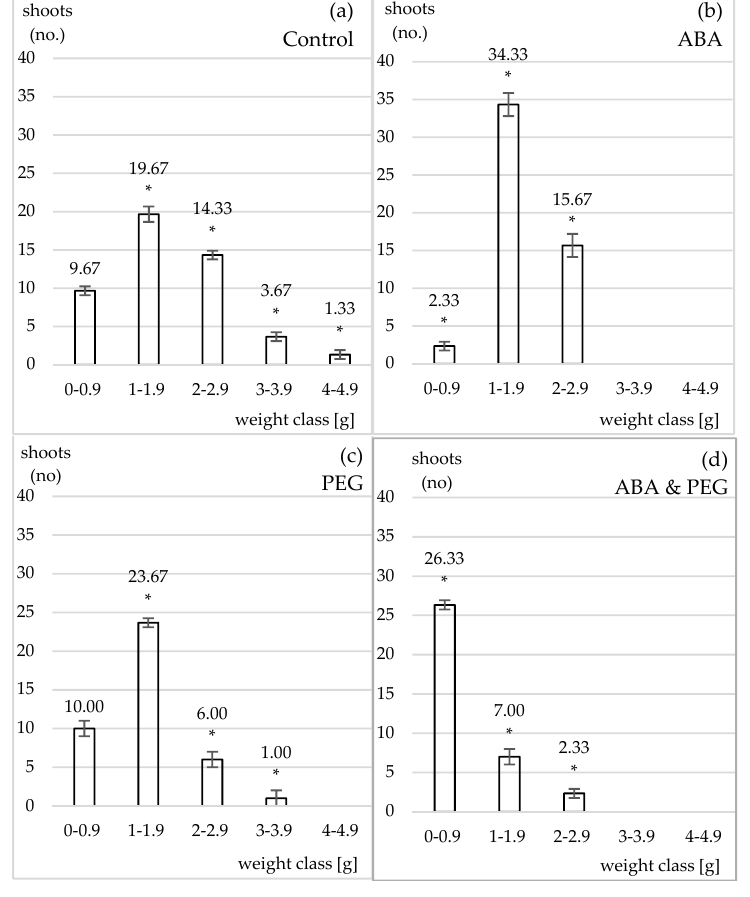
Figure 1. The shooting rate on fresh weight classes of morphogenetic hypocotyl of Nicotiana tabacum L., ‘Baladi’ was ceased for the highest class of fresh weight in case of control ( a ) compared to all variants cultivated on MS 62 modified culture media supplemented with hormones and ABA ( b ), PEG ( c ) and ABA & PEG ( d ) (stage no 1). * Significant differences: p < 0.05.